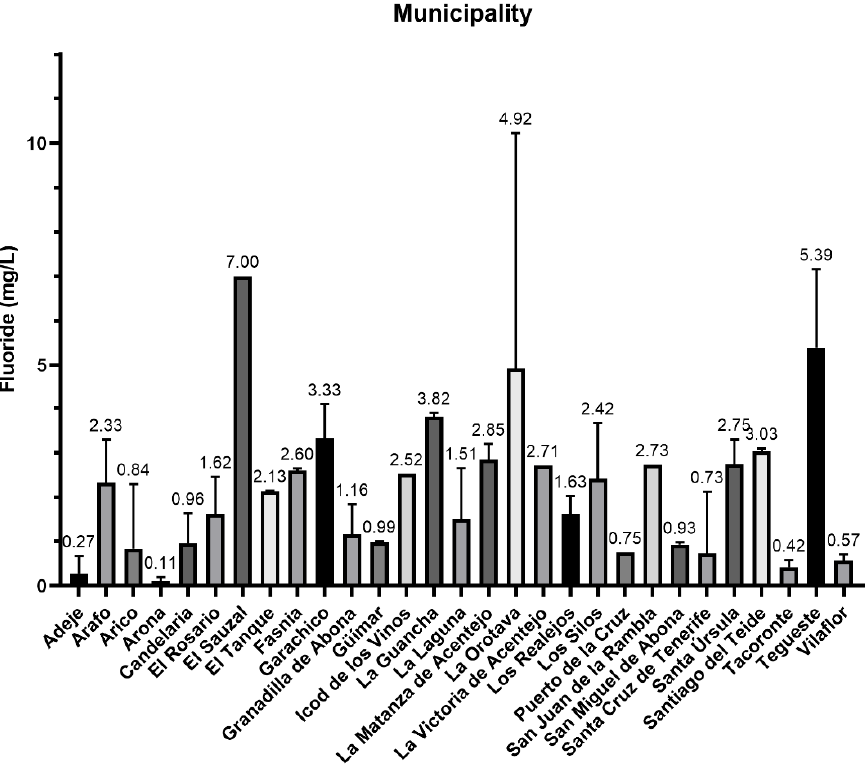
Figure 3. Fluoride content (mg/L) by municipalities in the Tenerife’s island.